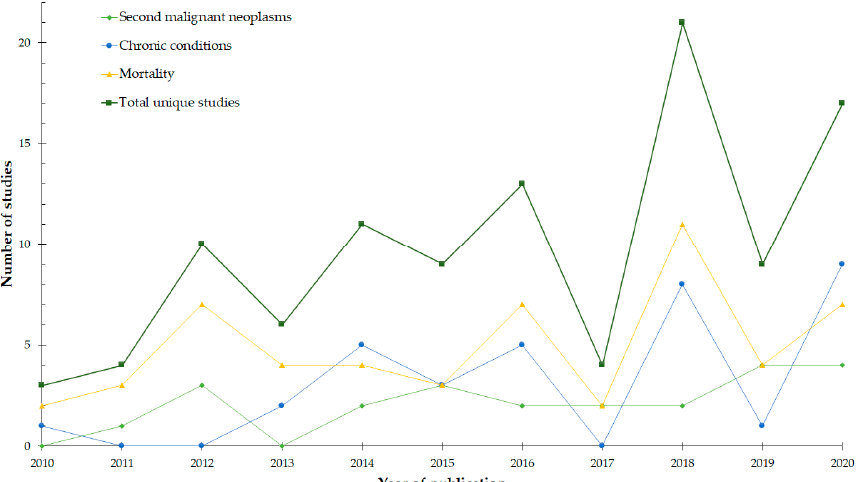
Figure 2. The number of studies included in the scoping review for each outcome of subsequent malignant neoplasms, chronic conditions, and mortality according to year of publication. Duplicates (studies containing information on more than one outcome) were removed from the line indicating the total number of studies.